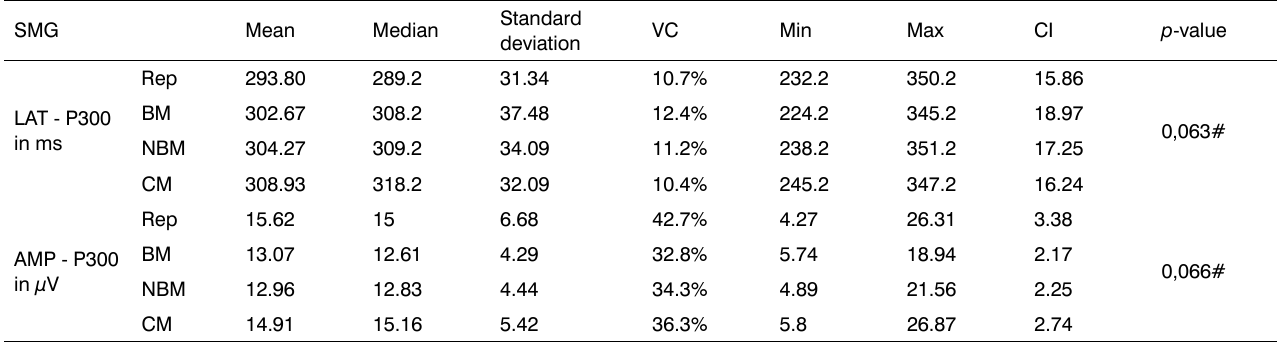
Table 3. p -values for the variables LAT-P300 and AMP-P300 for SMG. SMG Mean Median